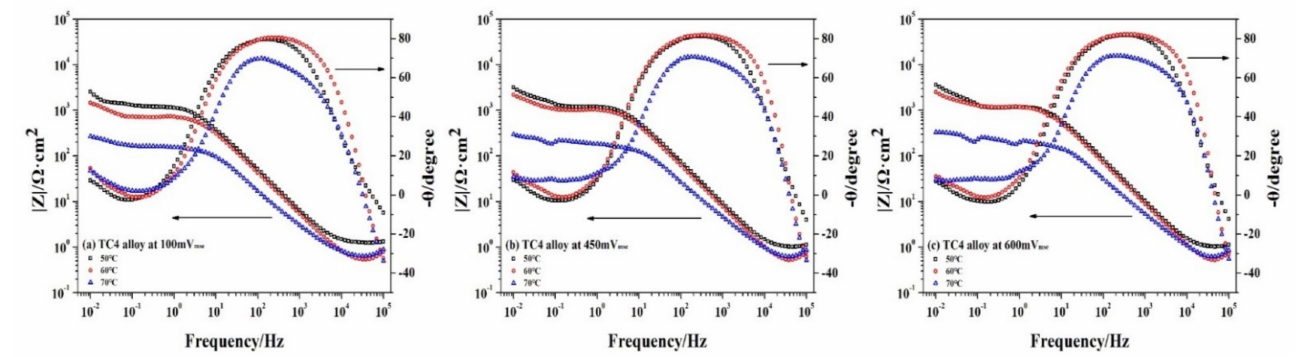
Figure 11. Bode plots for the TC4 alloy at 100 mV mse ( a ), 450 mV mse ( b ) and 600 mV mse ( c ).